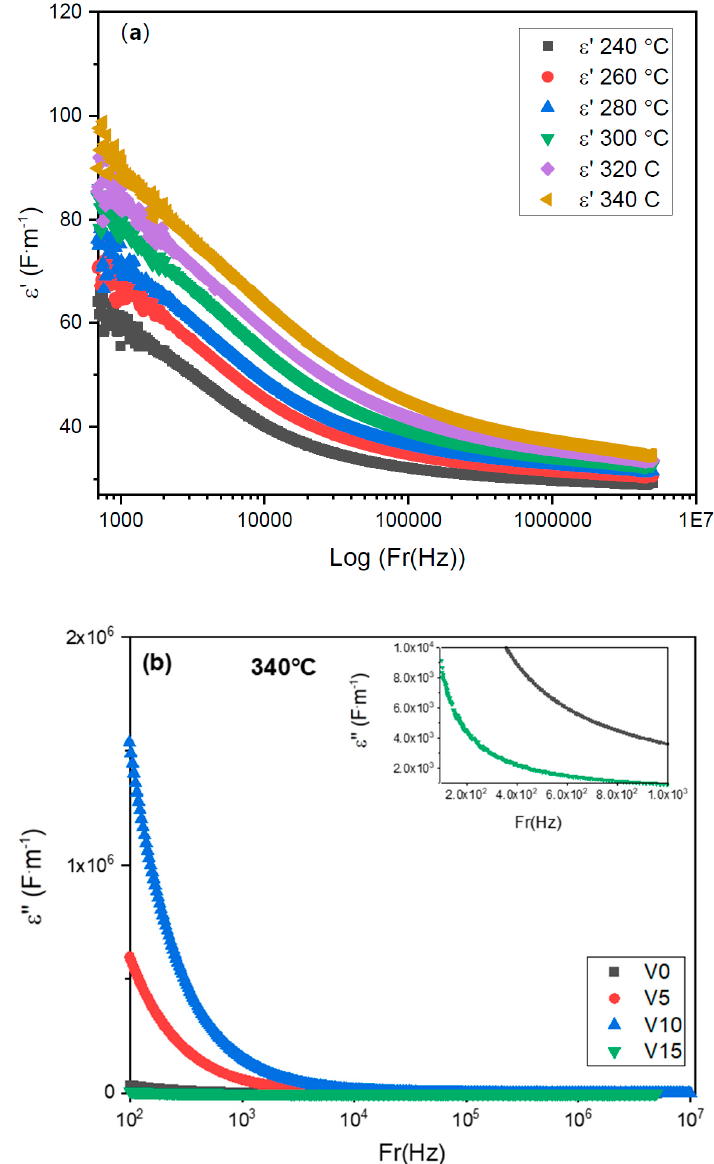
Figure 12. Frequency dependence of loss factor of ( a ) TZV15 glass sample at different temperatures ( b ) all TZV glass samples at T = 340 °C.